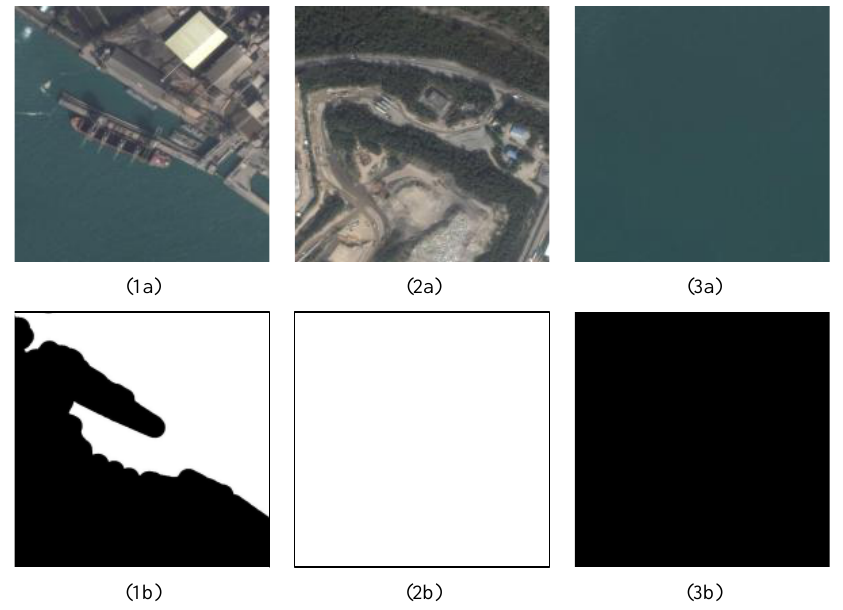
Figure 5. The top part are 3 remote sensing images slices, and the bottom part are the corresponding binary image slices. ( 1b ) The mean value of the binary image slice is 0.52, which is smaller than the threshold, so the image slice in ( 1a ) should be sent to the ship detection network. ( 2b ) The mean value of the binary image slice is 1.0, which means that the image slice in ( 2a ) only contains land, and can be skipped directly. ( 3b ) The mean value of the binary image slice is 0, which means that the image slice in ( 3a ) only contains